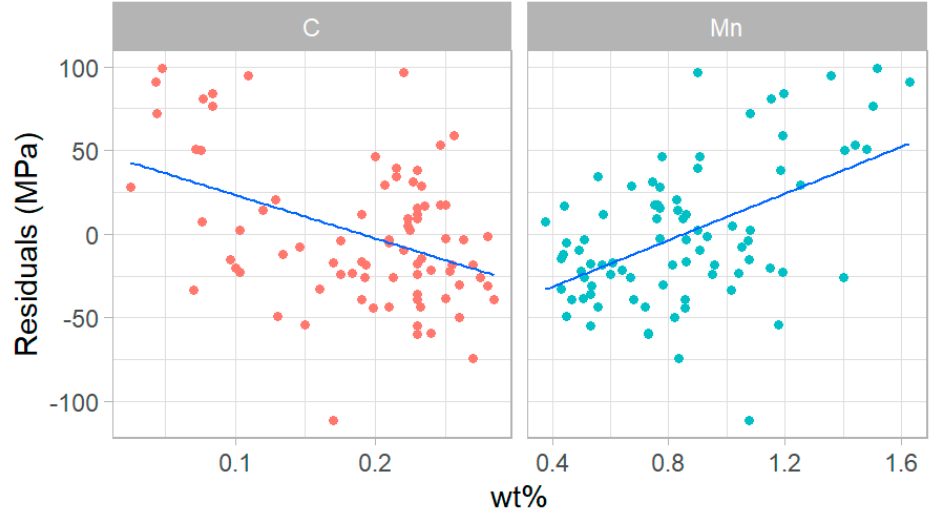
Figure 9. Error between mean IIT YS and mean tensile YS for each feature plotted against mass fraction manganese (wt.%) and mass fraction carbon (wt.%).